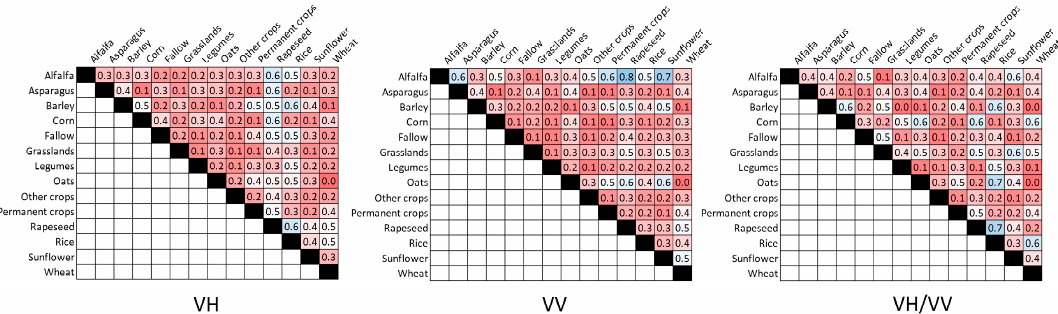
Figure 4. Mean JM Distance per crop pair for the median backscatter time series of the different polarizations during the whole period of study.